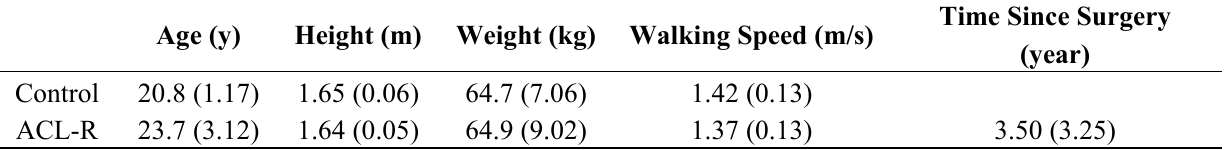
Table 1. Anthropometric, gait velocity and surgical data. Averages are presented with standard deviations in brackets. Differences between group means are non-significant ( p > 0.05) except for age ( p <